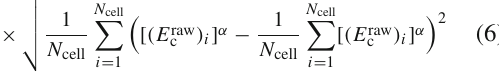
Fig. 9 Distributions of C tot obtained using experimental electron- enriched beam particles with an energy equal to 20 GeV ( a ) and sim- ulated electrons with E beam equal to 18 GeV ( b ) and 30 GeV ( c ). Fit Gaussian functions obtained using the method of the least squares are superimposed in red on the distributions